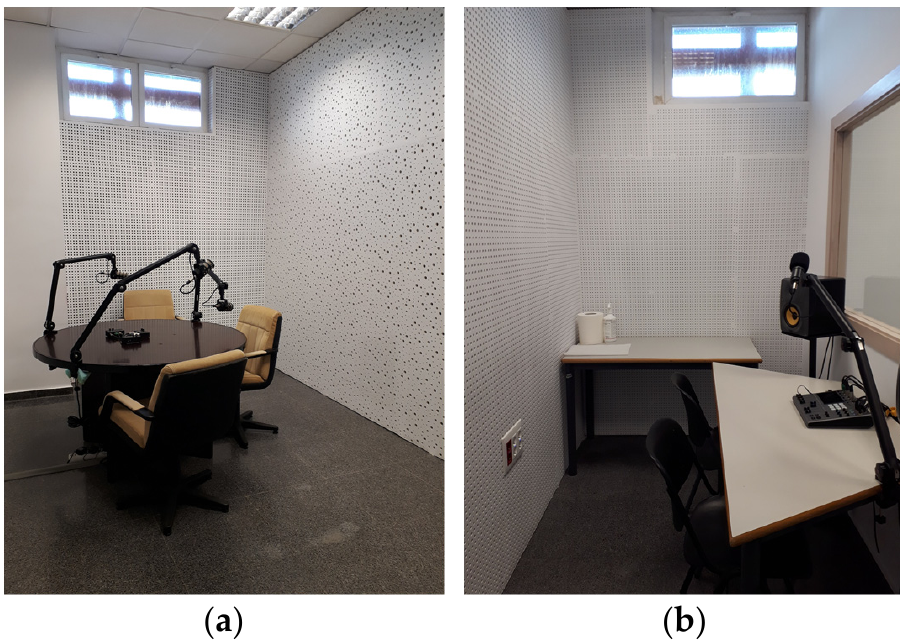
Figure 16. Images of the rooms with the proposed multifunctional solution installed: ( a ) studio room; ( b ) control